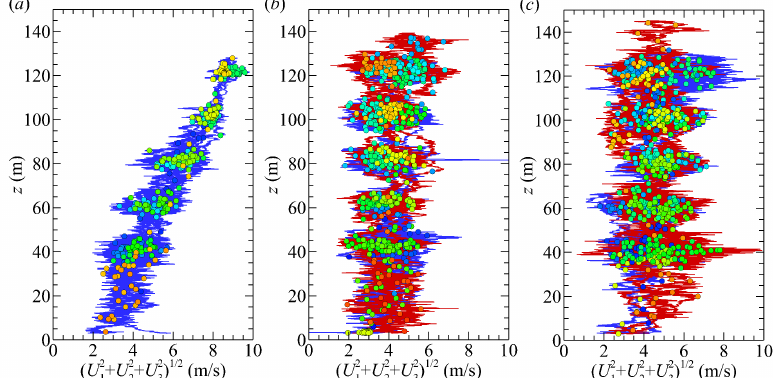
Figure 11. Profiles of wind velocity magnitude measured by the two aircraft during ( a ) flight 1, ( b ) flight 2, and ( c ) flight 3. Symbols represent a 5 s separation in time and color of symbols represents position in time (dark blue indicates the start of flight transitioning to red towards the end of flight). The blue lines indicate measurements made by BC5A and the red lines indicate measurements made by